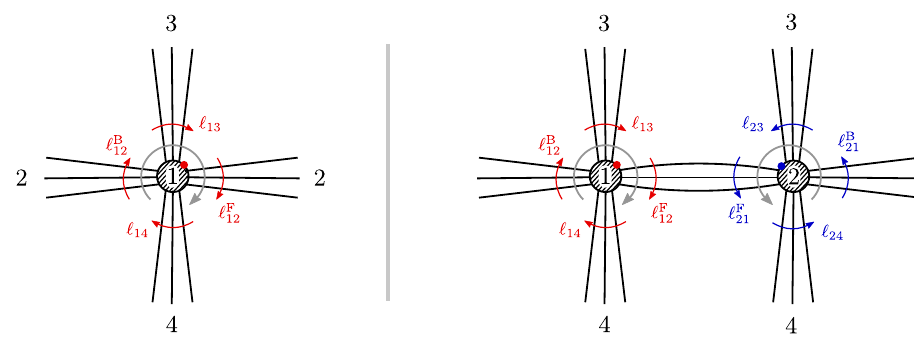
Figure 2 . Spin-chain picture for the spacetime dressing. We have one BMN operator on the left panel and two BMN operators on the right panel. We denote the number of propagators between two points i; j as ‘ ij . When there are two possible ways for the Wick contraction, one in the front and one in the back, we denote the corresponding number of propagators by ‘ F